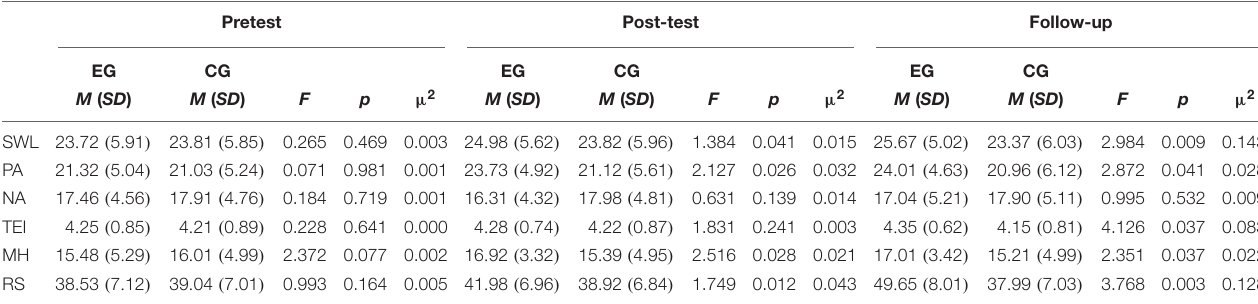
TABLE 3 | Averages and standard deviations in the variables under study (subjective well-being, trait emotional intelligence, mental health, and resilience) in the experimental and control groups. Pretest Post-test Follow-up